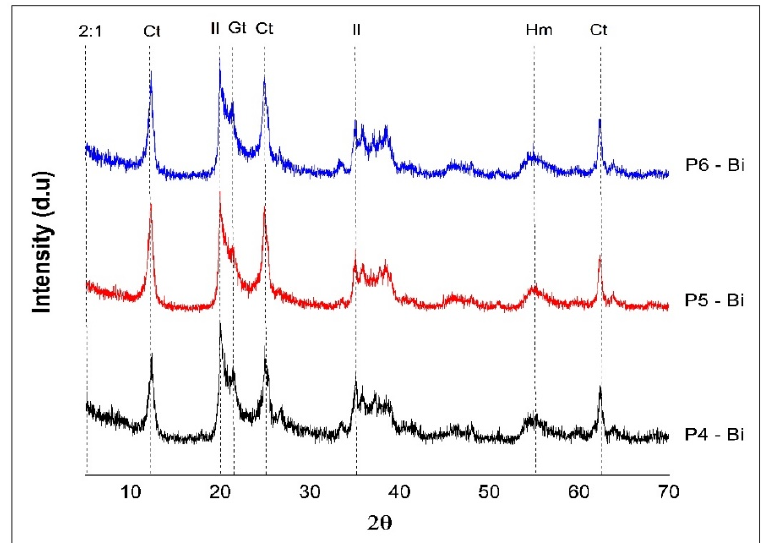
Figure Figure 3. XDR in the natural clay of the diagnostic horizons of the less developed horizons. 2:1: 2:1- type mineral clay; Ct: Kaolinite; Il: Illite; Gt: Goethite; Hm: Hematite; P4: Haplic Cambisol—Bi; P5: Haplic Cambisol—Bi; P6: Haplic Cambisol—Bi.